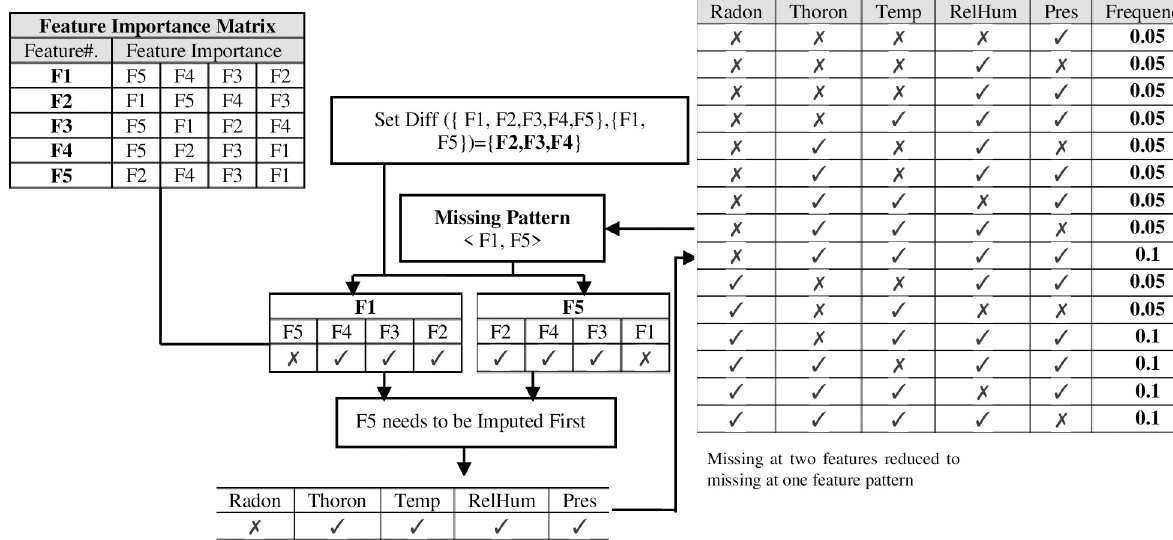
Fig 4. Proposed methodology to select a feature needed to imputed first in imputation by feature importance (IBFI) method.